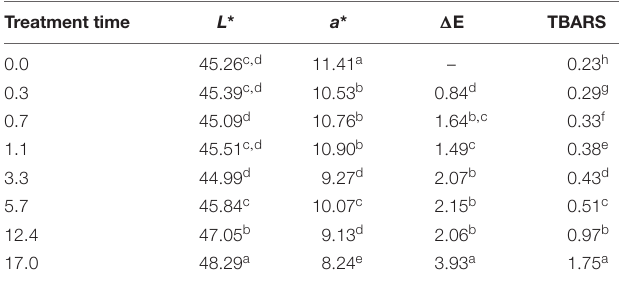
TABLE 2 | Instrumental color parameters and lipid oxidation estimated in dry-fermented sausages treated by UV-C radiation. Treatment time L * a * (cid:49) E